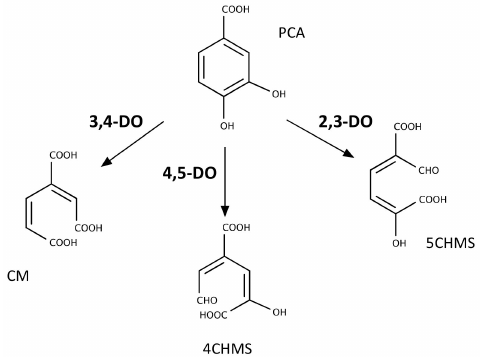
Figure 3. Types of dioxygenase-mediated reactions involved in PCA cleavage by bacteria. DO: dioxygenase; CM: 3-carboxy-cis,cis-muconate; 4CHMS: 4-carboxy-2-hydroxymuconate semialdehyde; 5CHMS: